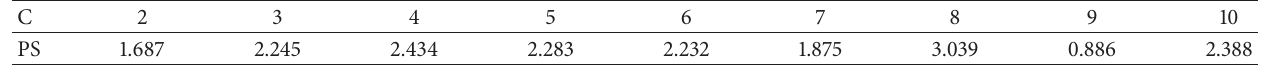
Table 2: PS validity indices for different numbers of clusters.